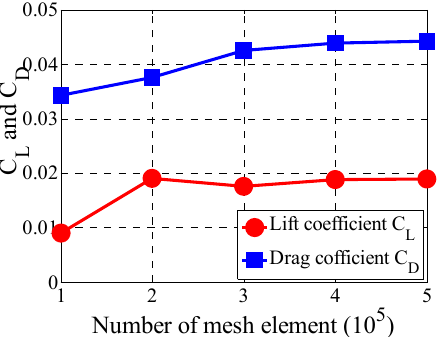
Figure 5. Mesh independence test for flow over the base hybrid airship.